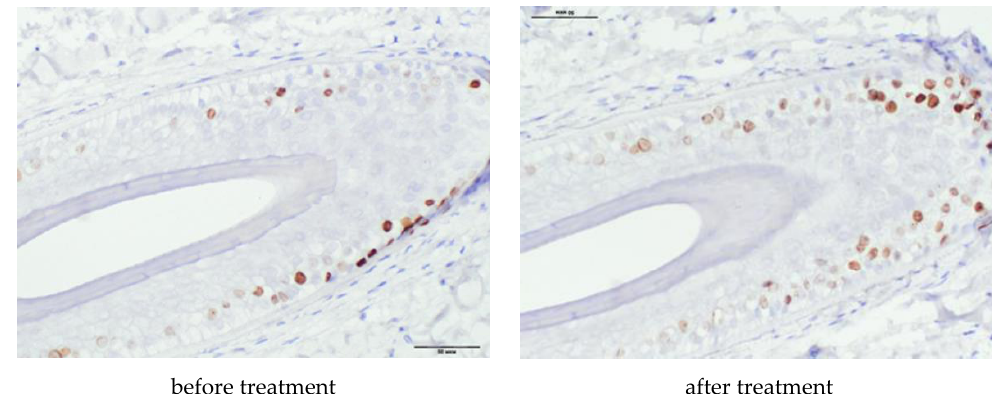
Figure 7. Number of Ki 67+ cells, magnification ×400. Dkk-1 expression was absent in all medicines before and after treatment.